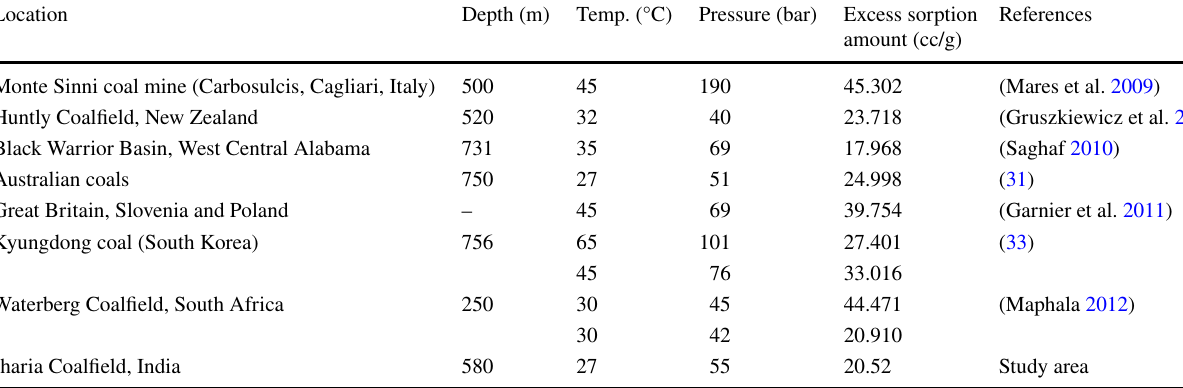
Table 3 Sorption capacity of coal at different coalfields worldwide